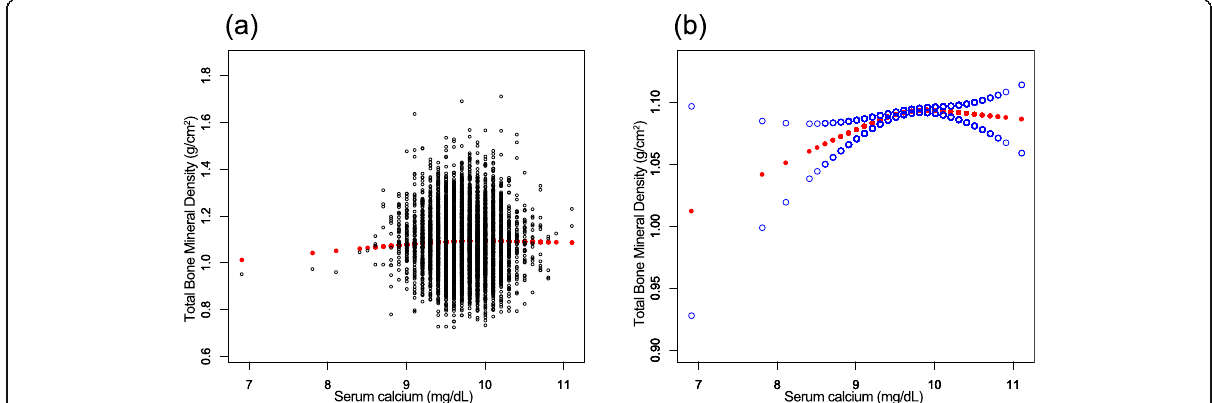
Fig. 1 The association between serum calcium and total bone mineral density. a Each black point represents a sample. b Solid rad line represents the smooth curve fit between variables. Blue bands represent the 95% of confidence interval from the fit. Adjusted for age, gender, race/ethnicity, income to poverty ratio, education, physical activity, body mass index, calcium supplementation